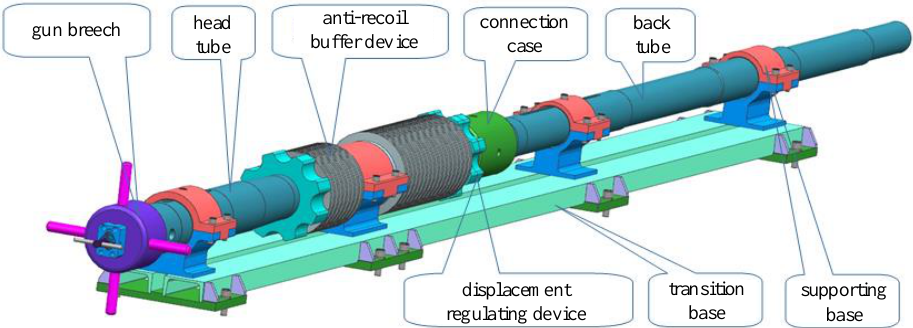
Figure 2. Sub-caliber ultra-high speed fragment loading device.